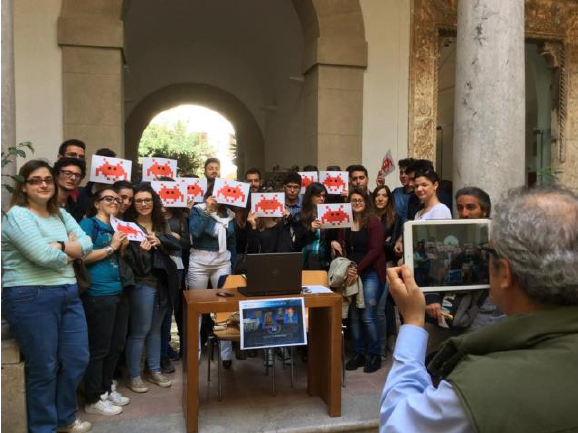
Figure 2. The students at the inauguration of the 3D # digitalinvasion